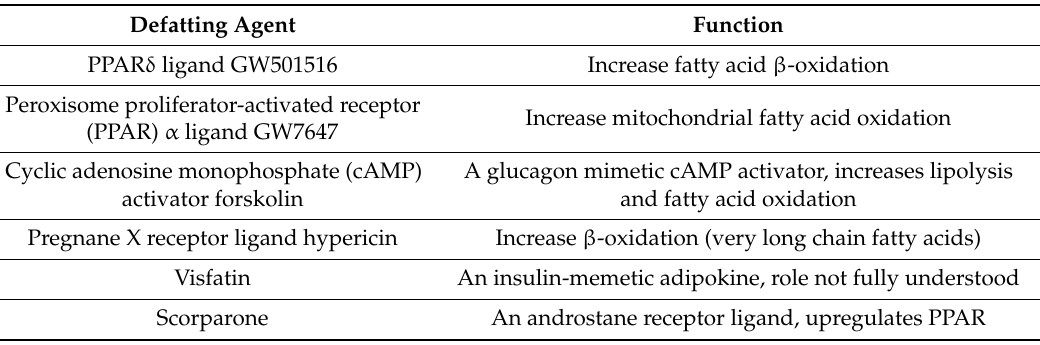
Table 4. Defatting